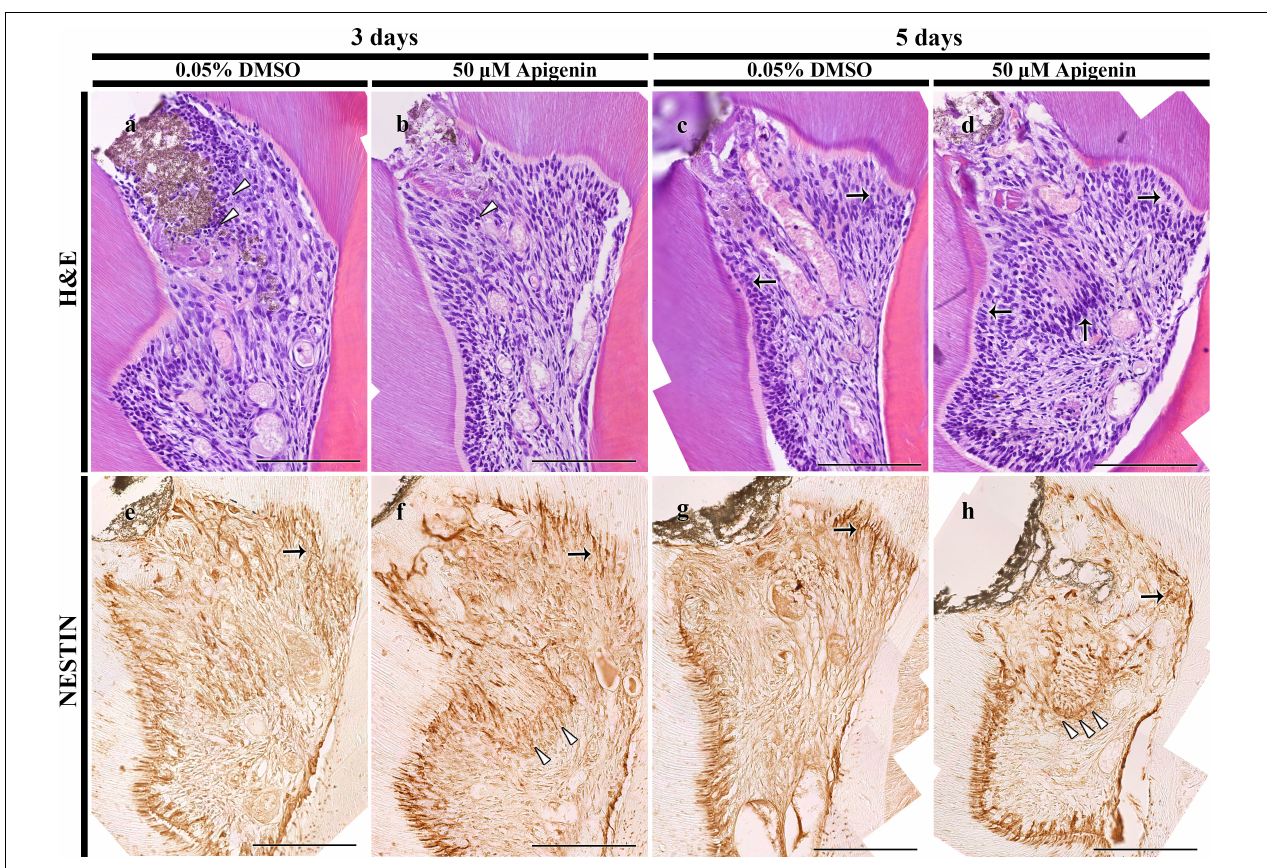
FIGURE 2 | H&E staining and immunolocalization of NESTIN. H&E staining showing more disintegrated cells in the DMSO-control than apigenin-treated pulp cavity after 3 days (arrowheads) (a,b) . Increased pulp and odontoblast cells are observed in the apigenin-treated specimen after 5 days (arrows) (c,d) . The intense immunolocalization of NESTIN is observed beneath the exposed pulp (arrowheads) and reactionary dentin-forming region (arrows) in the apigenin-treated pulp cavity in both 3- and 5-day specimens (e–h) . Scale bars: 50 µ m (a–h)